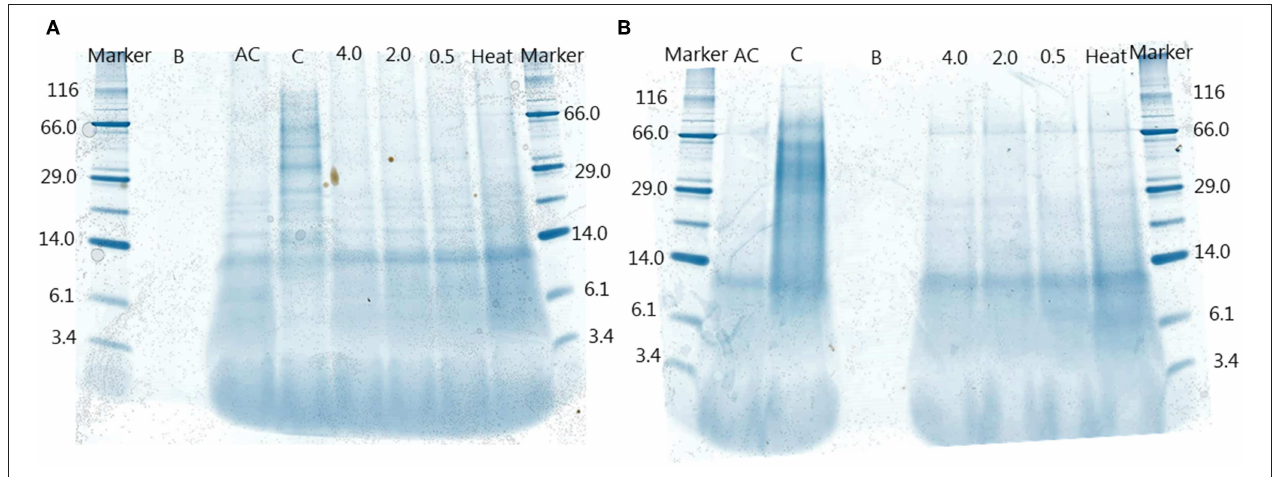
FIGURE 7 | SDS-PAGE analysis of supernatant after precipitation from (A) red clover (B) ryegrass. C indicates the cleared juice, AC indicates acid cleared juice, B indicates blank lanes, and the numbers are N eq of lignosulfonates.